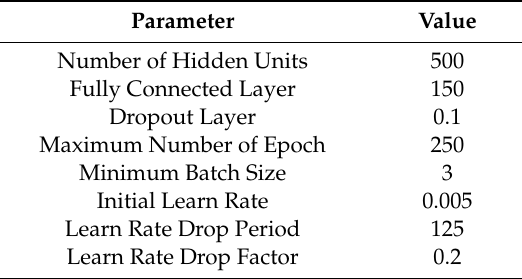
Table 6. Tuned parameter for LSTM